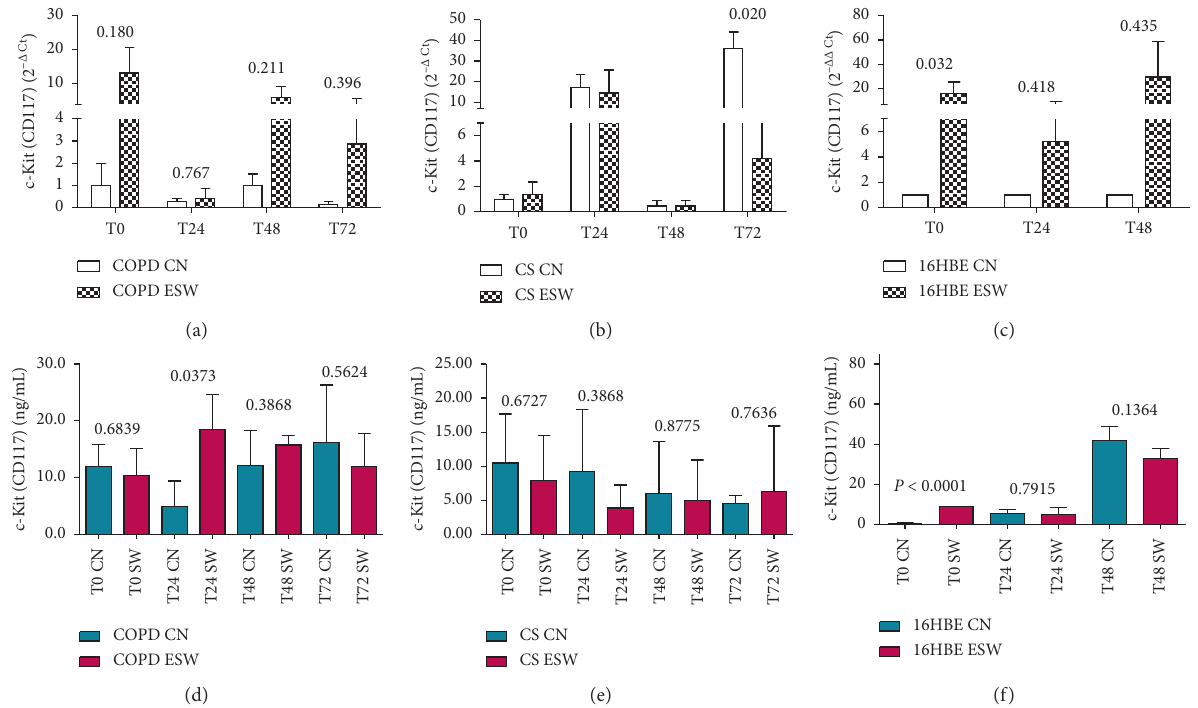
Figure 2: C-Kit (CD117) mRNA (a, b, c) and protein (d, e, f) expression after ESW treatment in primary bronchial fibroblasts of COPD patients (a, d), primary bronchial fibroblasts of control smokers (b, e), and bronchial epithelial cells (c, f). In bronchial epithelium (16HBE) c-Kit increased at mRNA (c) and protein (f) levels. In primary bronchial fibroblasts of COPD patients, c-Kit increased at protein level (d). T - test was used for comparative purposes, and p values are reported in the graphs.